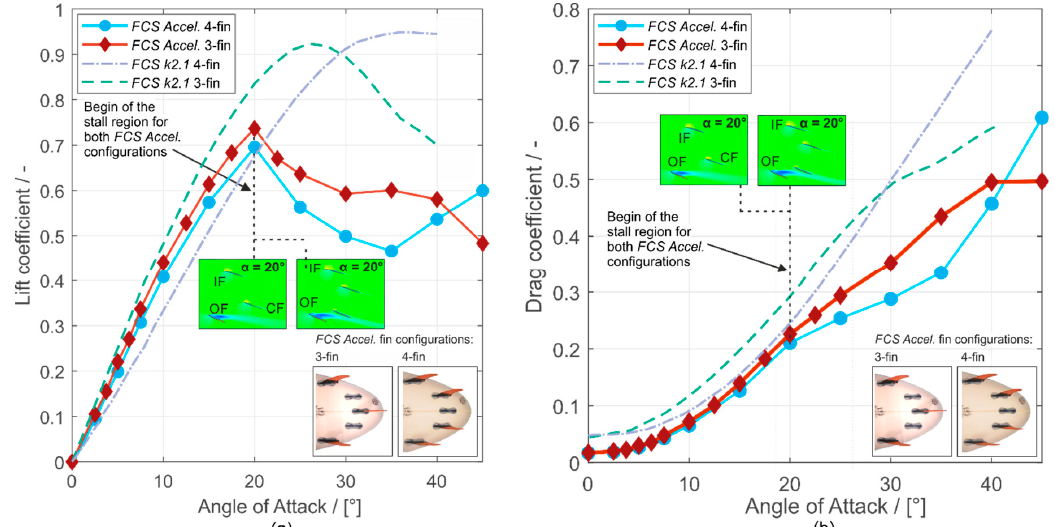
Figure 17. ( a ) Mean lift coefficient of the entire fin configuration versus the angle of attack. ( b ) The mean drag coefficient of the entire fin configuration versus the angle of attack. The solid lines present the commercial 3- and 4-fin configurations with the FCS Accelerator fins from this study and [11]. The dashed lines present the results of [13] with 3- and 4-fin configurations with plugged FCS k2.1 fins.